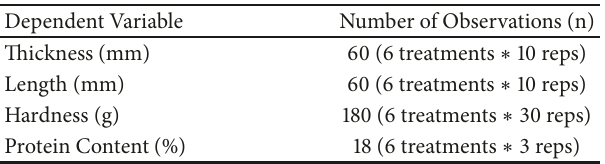
Table 1: Dependent variables and number of observations for statistical